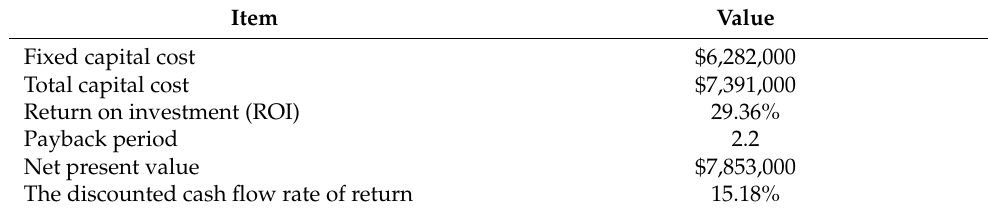
Table 9. Economic evaluation summary of the reactive distillation-based process for glycerol